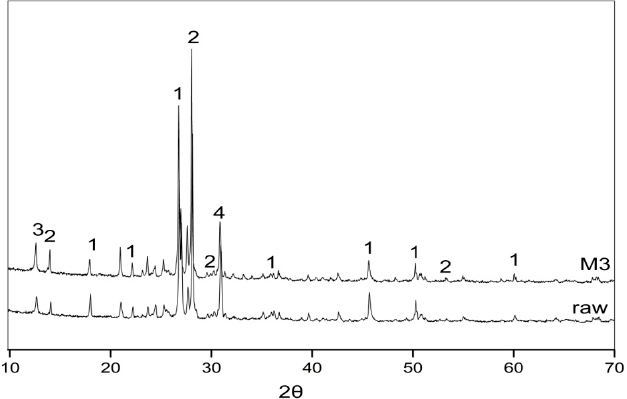
Figure 8. XRD result of raw copper-mine tailings and sample M3 (after 3 h of grinding) (1 quartz, 2 albite, 3 chlorite, 4 dolomite).